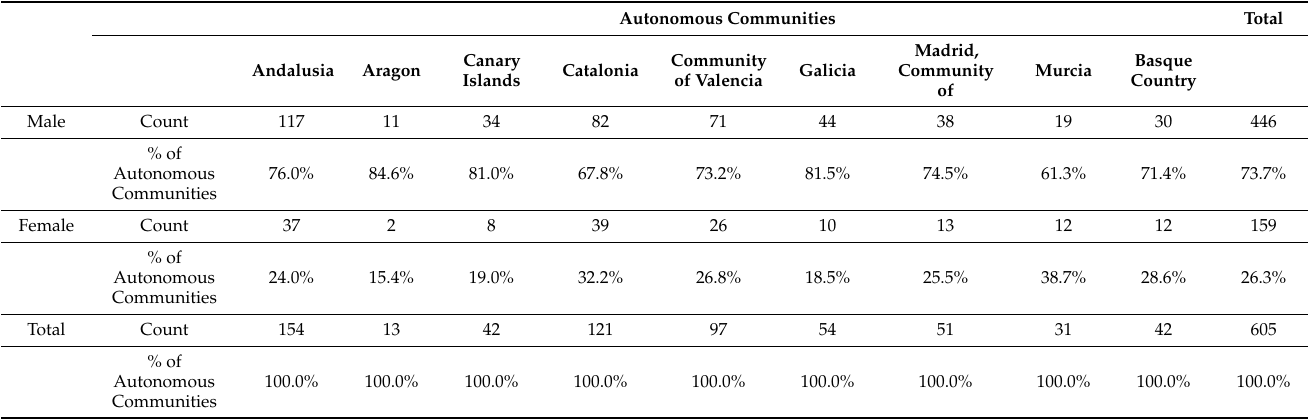
Table 2. Mayors/mayoresses by autonomous community.